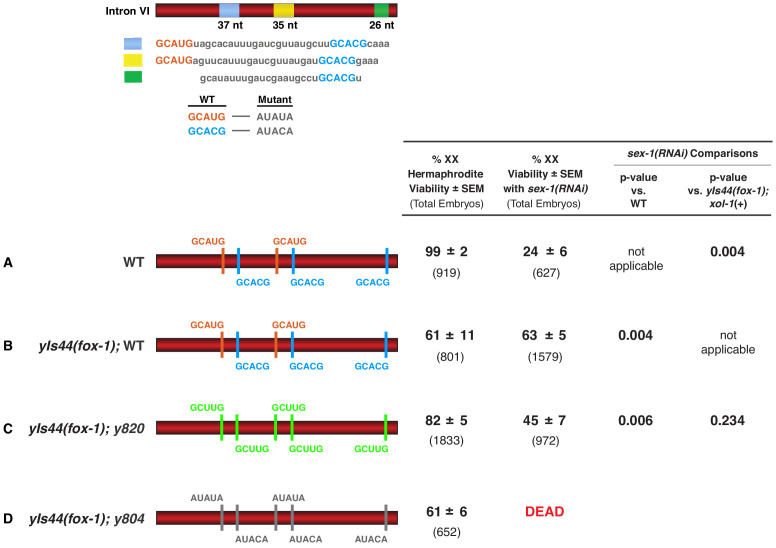
High FOX-1 levels in XX animals repress xol-1 with multiple low-affinity GCUUG motifs in intron VI.Diagrams on the left show the configurations of wild-type and mutant motifs in intron VI of XX animals with either two doses of fox-1 (A) or high doses of fox-1 supplied by an integrated array (yIs44) carrying multiple copies of fox-1 (B–D). Comparison is shown for viability of these different XX strains with sex-1(RNAi) or without. p-values compare the significance of viability differences among sex-1(RNAi) XX animals. High levels of FOX-1 are not fully tolerated by XX animals, because only 63% of these animals are viable. Nonetheless, it is evident that high levels of FOX-1 suppress the XX-specific lethality caused by sex-1(RNAi) when intron VI has five wild-type high-affinity GCAUG and GCACG motifs (B) or five low-affinity GCUUG motifs (C) but not five mutant motifs (D).